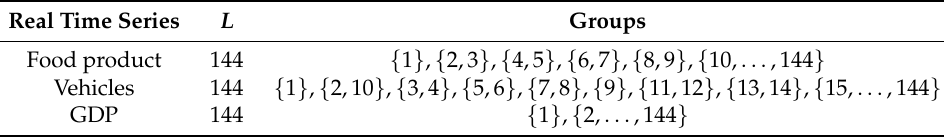
Figure 9. Scatter plots of eigenvectors for food products time series. Table 2. Identified groups of the real time